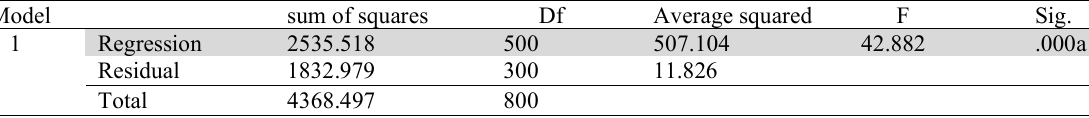
Analysis of variance